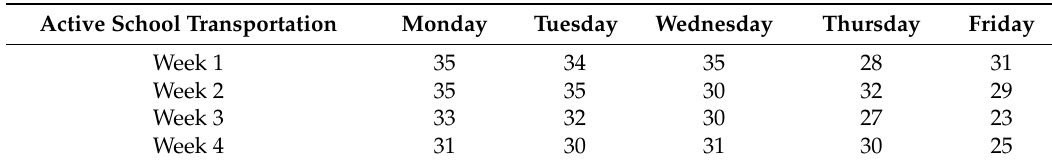
Table 3. A summary of the joint progress bar.